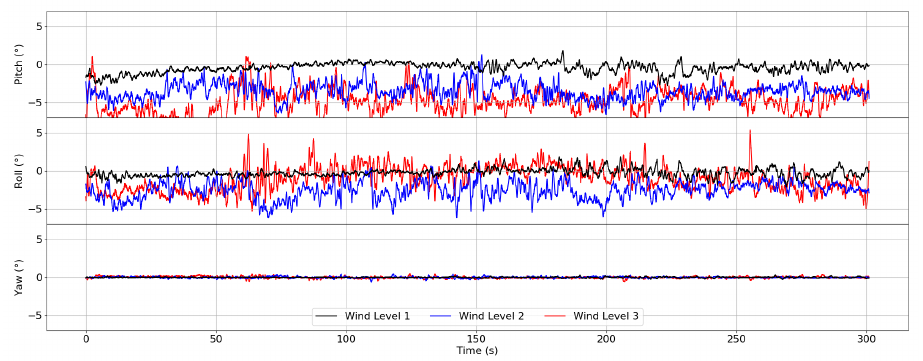
Figure 10. Comparison of DJI M600